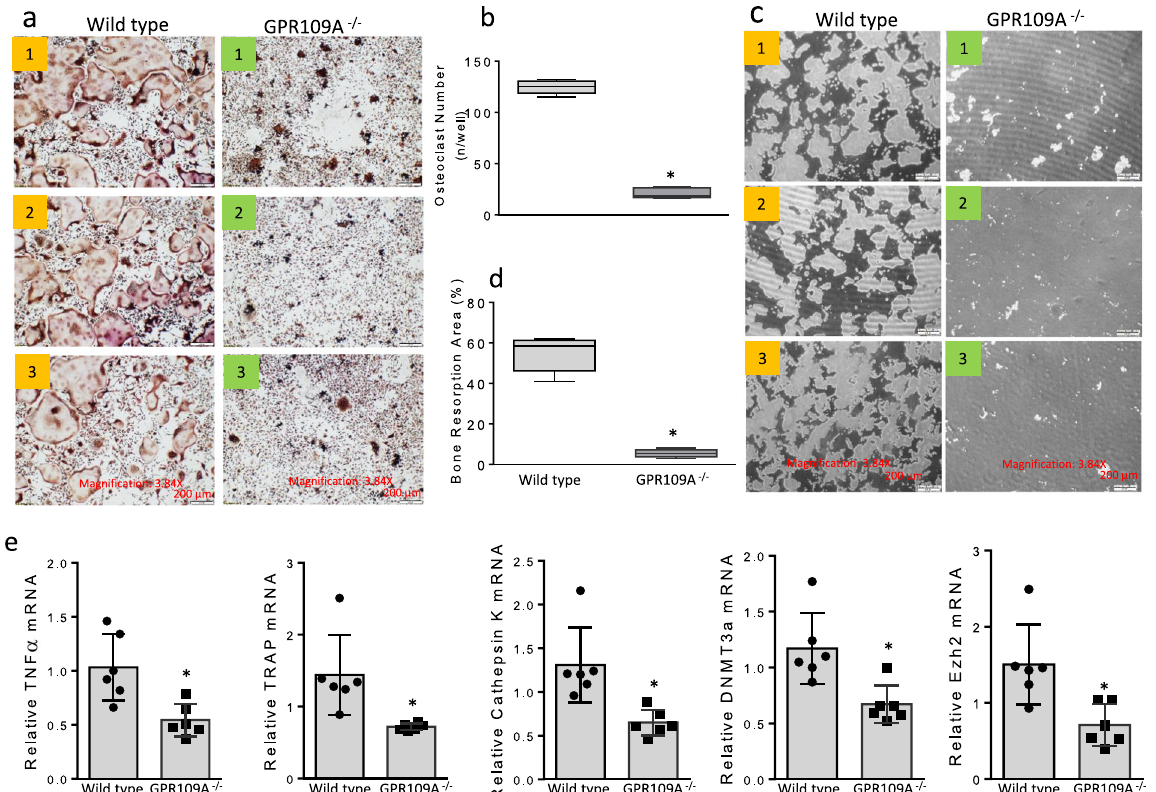
Fig. 5 Decreased osteoclastogenesis in GPR109A − / − mice in ex vivo non adherent bone marrow cell culture. a Bone marrow cells were isolated from 4- week-old male wild type and GPR109A − / − mice and suspended for 48 h, non-adherent bone marrow cells were re-cultured in the presence of 50 ng/ml RANKL for 5 days. Representative pictures showing osteoclast morphology from 3 different individual wild type or GPR109A − / − mice after TRAPase staining. b Osteoclast number per well with triplicates for samples from each mouse. c Non-adherent bone marrow cells from wild type and GPR109A − / − mice were cultured for osteoclast resorptive activity in corning osteo assay plates. Pictures showing resorption pits (white spots/areas) without Von Kossa staining. d Percentage of bone resorption area per well with triplicates for samples from each mouse. e Total RNA was isolated from non-adherent bone marrow cells from wild type and GPR109A − / − mice, real time RT-PCR shows relative NF k B, TRAP, Cathepsin K, DNMT3a, Ezh2 mRNA expression. Data are shown as the means ± SD of n = 6, gene expression was relative to housekeeping gene GAPDH. * p < 0.05 versus wild type control by t